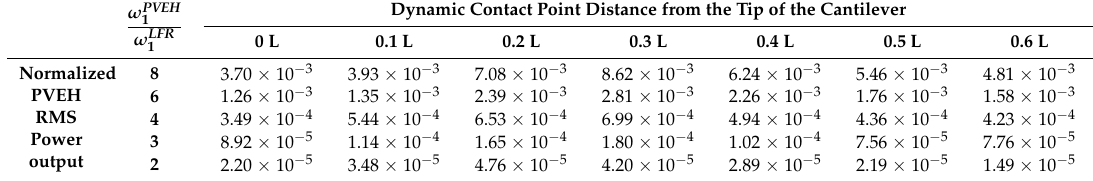
Table 5. Frequency normalized RMS power output [W] for different tandem configurations at optimal resistive loads.